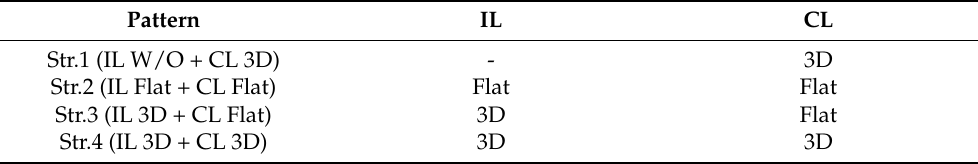
Table 2. CCLs with flat and 3D patterns at the CL and